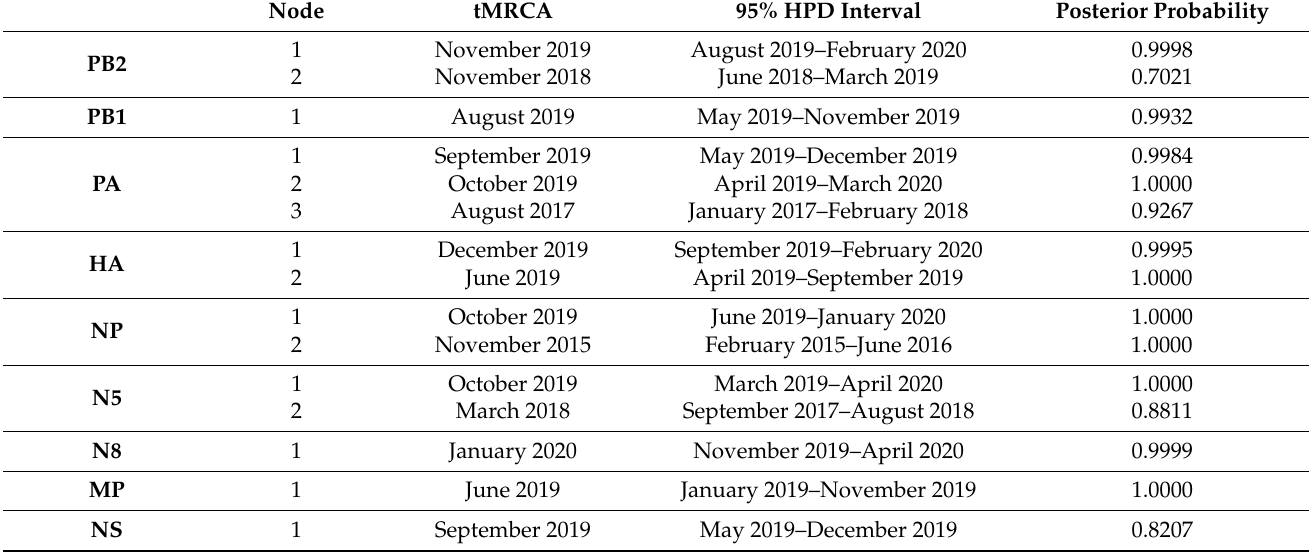
Table 1. Estimated tMRCA on PB2, PB1, PA, H5, NP, N5, N8, MP, and NS, and 95% HPD intervals calculated using BEAST analysis. The posterior probabilities are of the branch before the node. Node numbers are depicted in Figure 2 and in Supplementary Figure S2. tMRCA, time to most recent common ancestor; PB2, polymerase basic protein 2; PB1, polymerase basic protein 1; PA, polymerase acidic protein; H5, hemagglutinin subtype H5; NP, nucleoprotein; MP, matrix protein; NS, non-structural protein; HPD, highest posterior density. Node tMRCA 95% HPD Interval Posterior